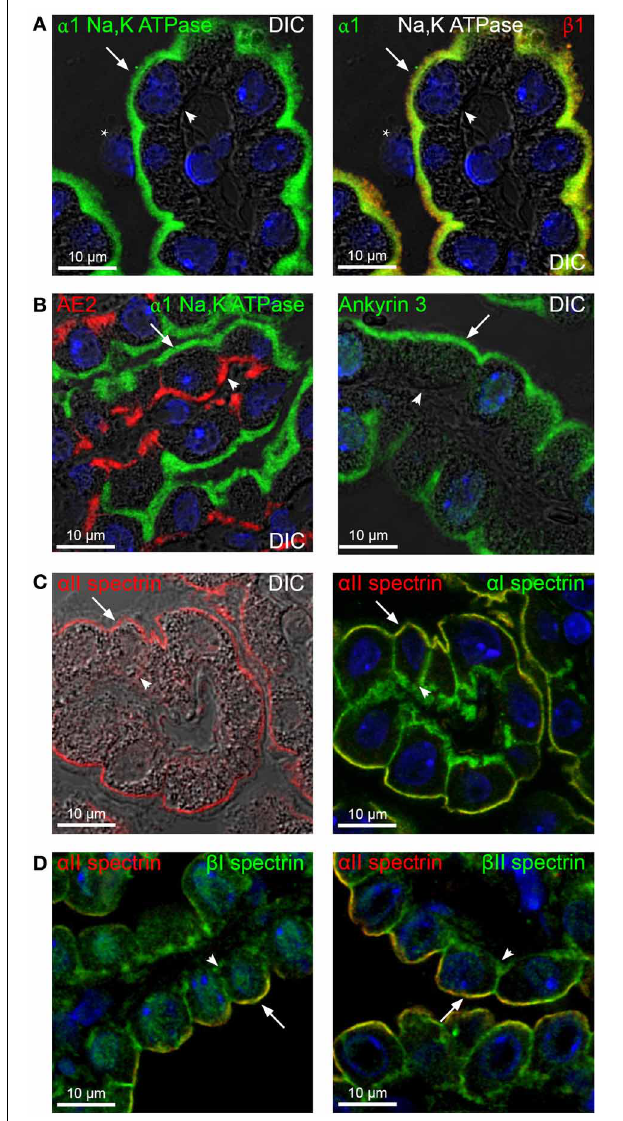
FIGURE 1 | Expression of spectrins and ankyrins in the choroid plexus epithelium. Mouse brain sections were immunostained for Na + ,K + -ATPase α 1 subunit, and ankyrins 1-3, α I-II and β I-V spectrins (in green), as well as Na + ,K + -ATPase β 1 subunit and AE2 (in red). Yellow color indicates co-localization. (A) Immunohistochemical staining for Na + ,K + -ATPase α 1 subunit overlaid on differential interference contrast image (DIC, left panel). The same section was doublestained for Na + ,K + -ATPase α 1 and β 1 subunits (right panel). ∗ marks an apparent macrophage (Kolmer cell). (B) Double immunofluorescence staining for AE2 and Na + ,K + -ATPase α 1 (left panel), and immunohistochemical detection of ankyrin-3 with DIC (right panel). (C) Immunostaining for α II-spectrin overlaid on the corresponding DIC image (left panel). Double immunofluorescence detection of α II-spectrin and α I-spectrin (right panel). (D) Immunolabeling for β I- and β II-spectrins (left and right panel, respectively) in doublelabeling with α II-spectrin. Arrows indicate the luminal membrane, while arrowheads indicate the basolateral membrane. Cell nuclei were visualized by Topro nuclear staining